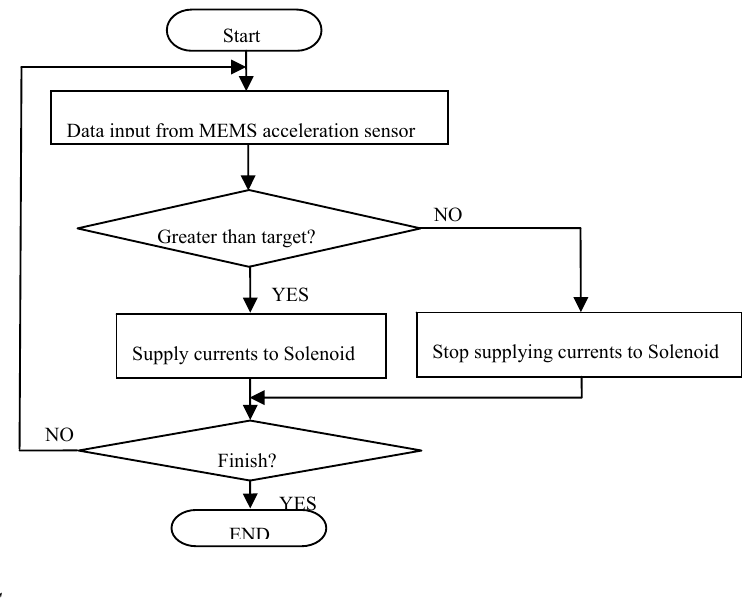
Figure 9. Operation algorithm of the developed system.